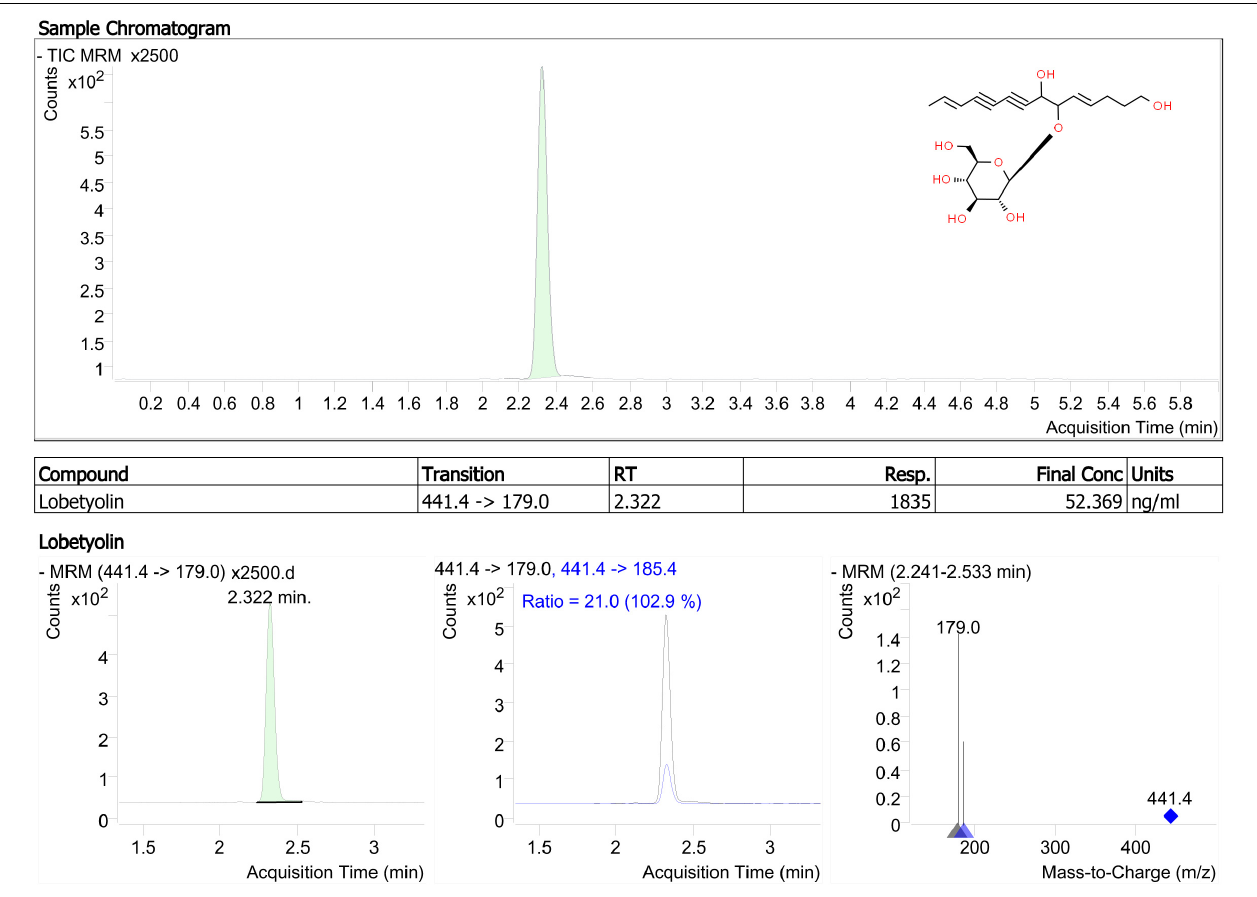
FIGURE 3 | Product ion mass spectra of [M + COOH] − ion of lobetyolin and chromatography peak of a representative JY sample (retention time 2.322